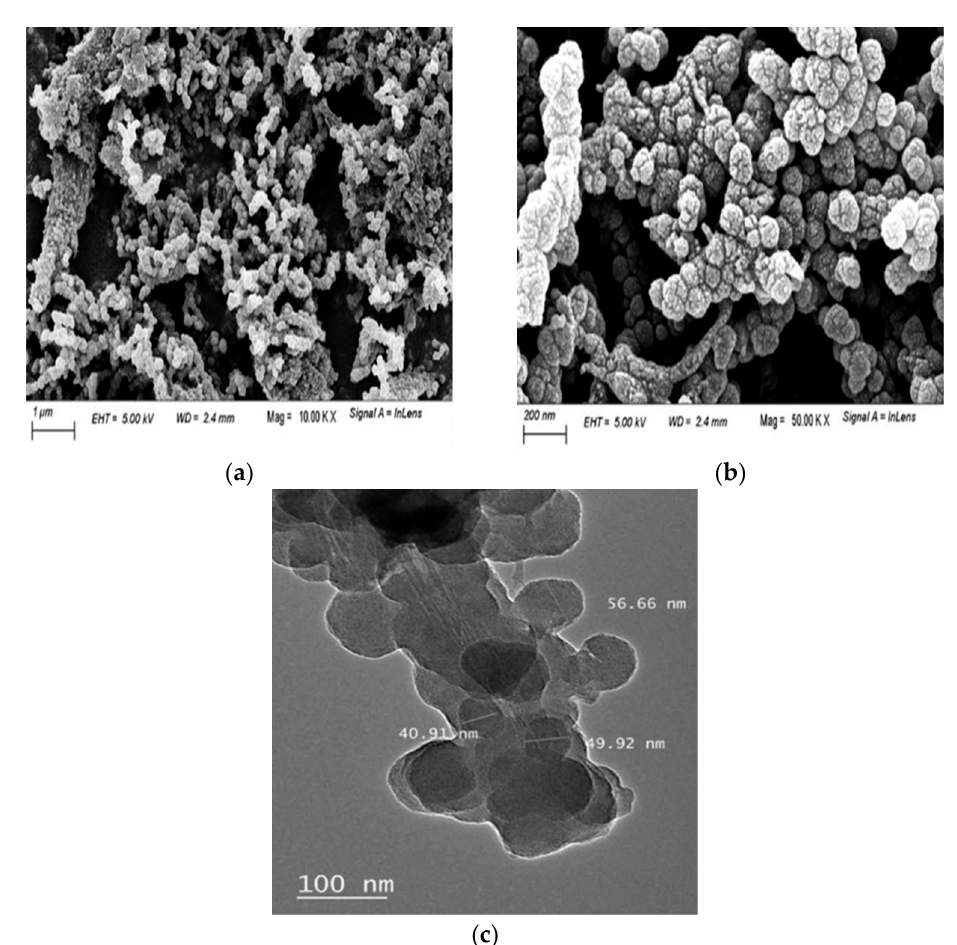
Figure 2. SEM images at different resolution ( a , b ) and TEM image ( c ) of the synthesized ppy/NC nanocomposite.